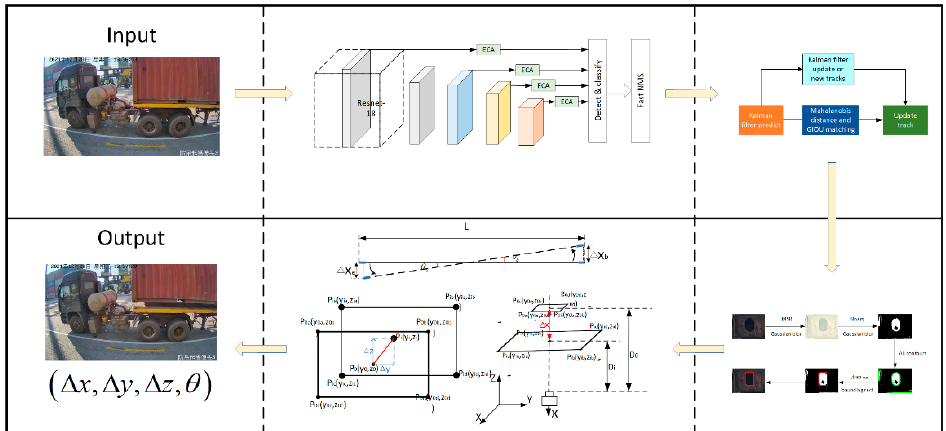
Figure 3. Algorithm flowchart.